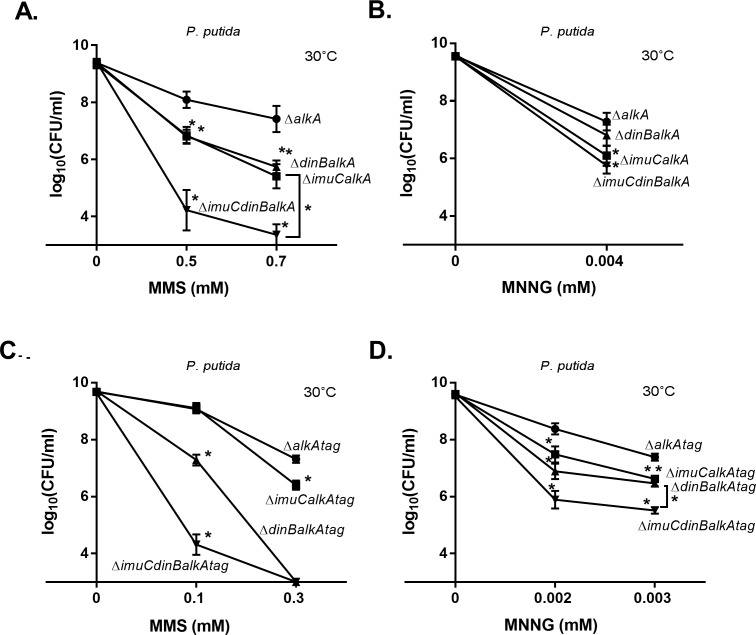
Sensitivity of P. putida ΔalkA and ΔalkAtag strains and their different TLS polymerase-deficient derivatives to MMS and MNNG.Sensitivity was estimated by spotting 10-fold dilutions of overnight cultures of P. putida ΔalkA (A, B) and ΔalkAtag (C, D) strains onto LB plates containing different concentrations MMS (A, C) and MNNG (B, D) and incubated at 30°C for 24 h. Data represents the mean (±95%CI) values. (●) ΔalkA; (■) ΔimuCalkA; (▲) ΔdinBalkA; (▼) ΔimuCdinBalkA (A, B); (●) ΔalkAtag; (■) ΔimuCalkAtag; (▲) ΔdinBalkAtag; (▼) ΔimuCdinBalkAtag (C, D). Asterisks indicate statistically significant difference (P < 0.05; two-way ANOVA followed by Tukey’s multiple comparison post hoc test) in the sensitivity of the ΔalkA or the ΔalkAtag mutant in comparison with the other deletion mutants. In addition, significant difference in sensitivity between the ΔdinBalkA or ΔimuCalkA and the ΔimuCdinBalkA (A); ΔdinBalkAtag or ΔimuCalkAtag and the ΔimuCdinBalkAtag strains (D) is indicated.